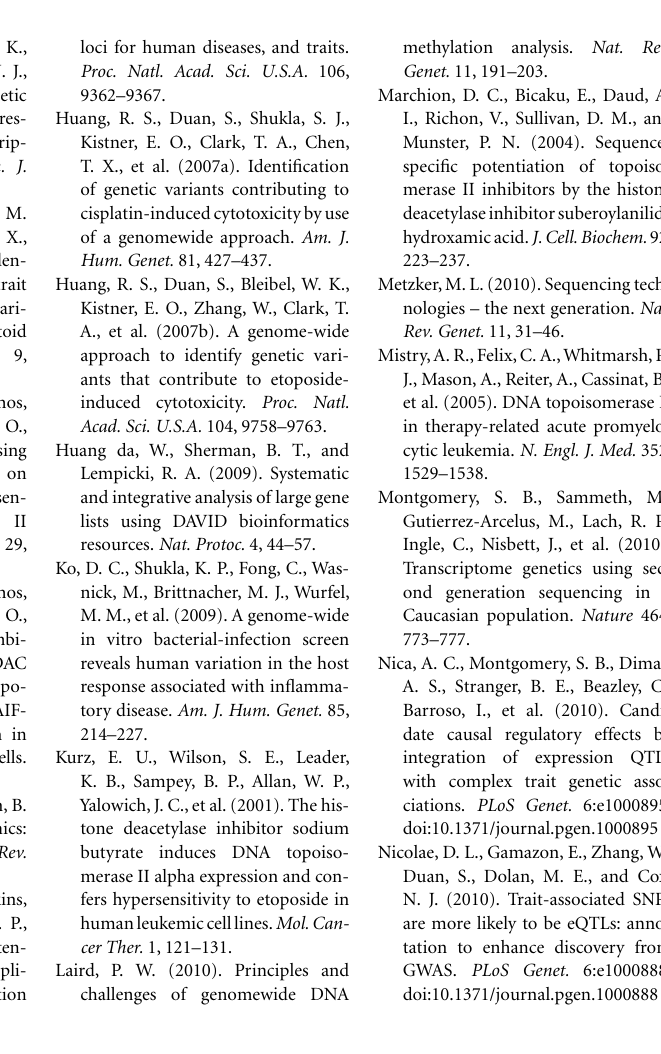
Table S2 |Top SNPs from etoposide GWAS. Table S3 |Top associations from the eFDR